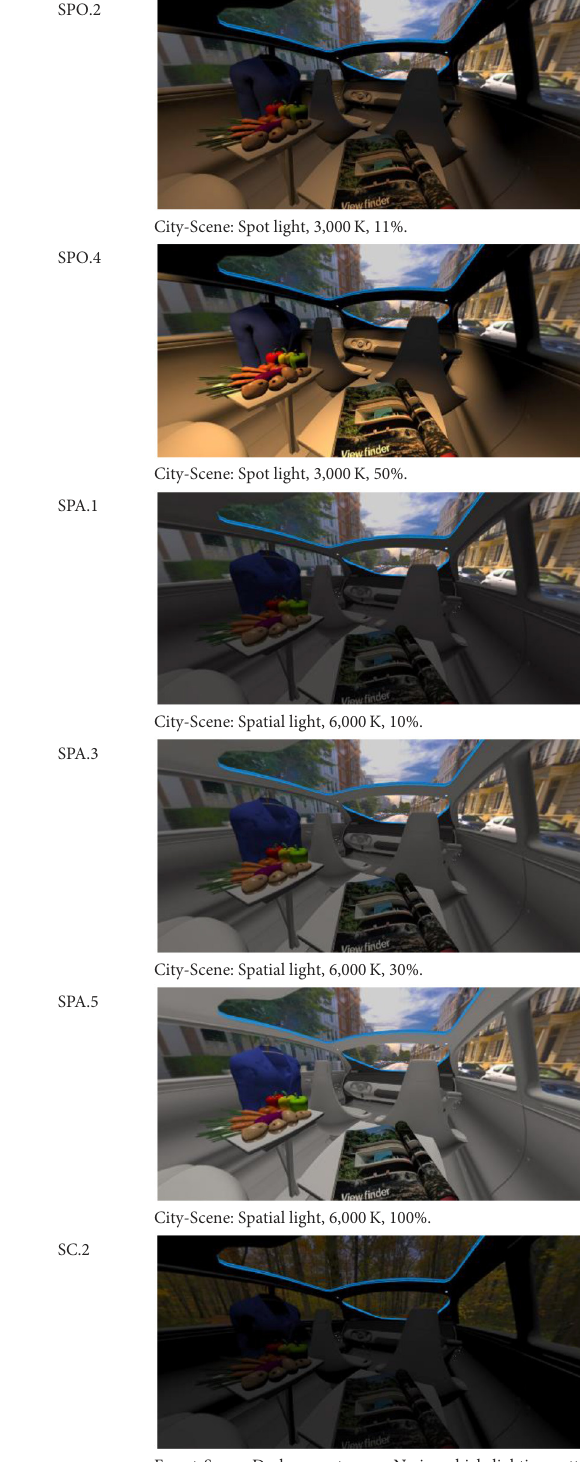
TABLE 3 Rating view of immersive 360 ◦ pre-rendered vehicle sceneries with spot light (SPO.1–5) and spherical lighting (SPA.1–5) including CCTs and applied brightness options in percentage values. SPO.1 SPO.2